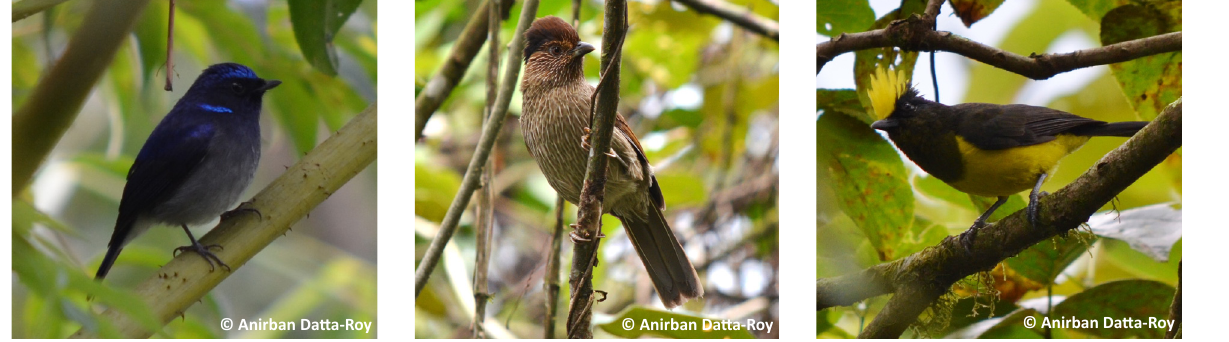
Image 8. Small Niltava Image 9. Striated Laughingthrush Image 10. Sultan Tit